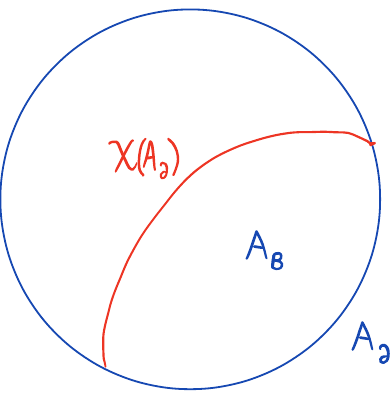
Figure 2 . A boundary region A ∂ , and its corresponding Ryu-Takayanagi surface χ ( A ∂ ) and bulk domain A B